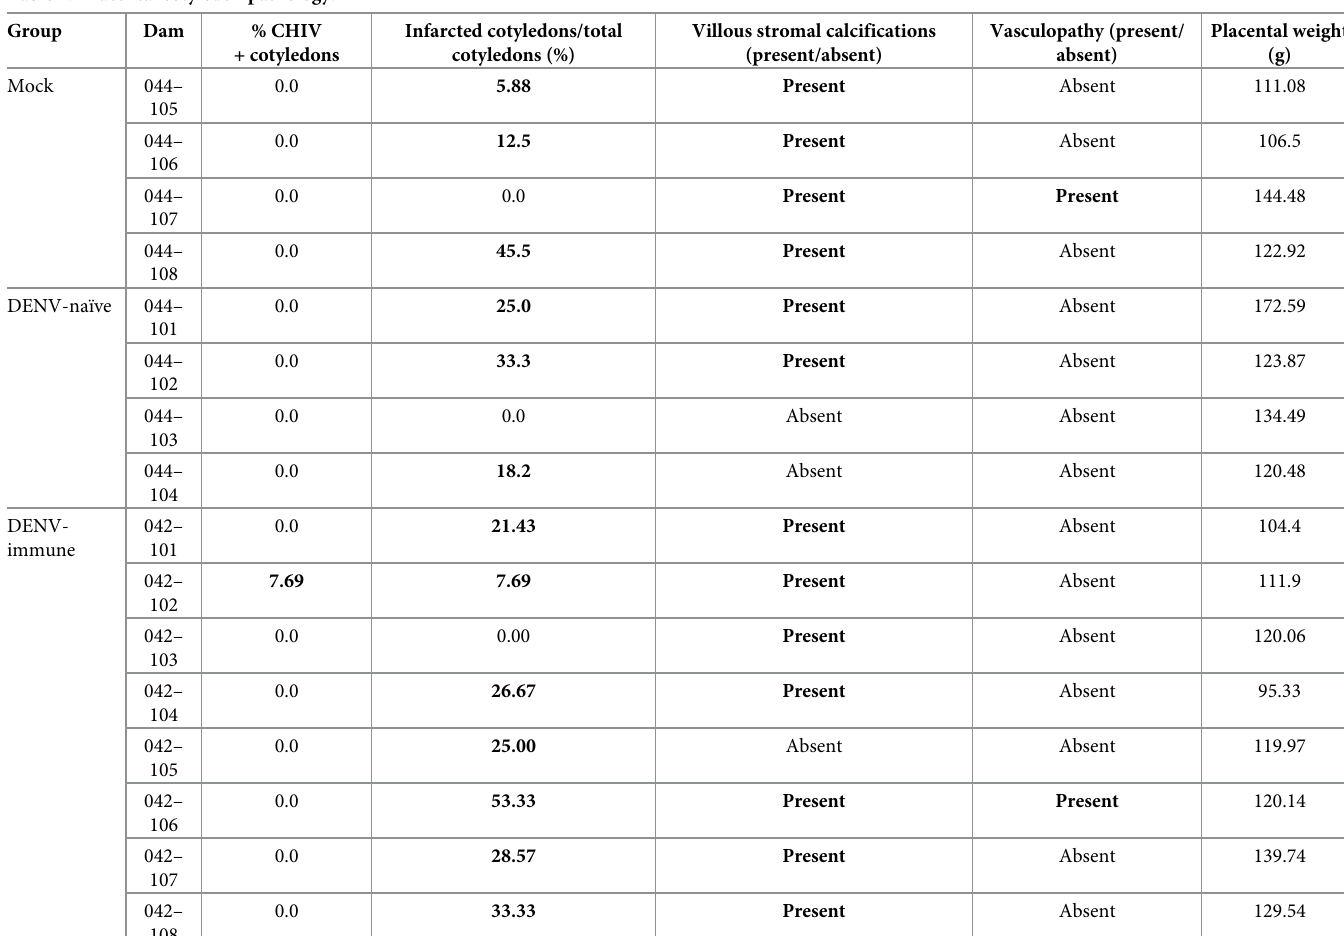
Table 1. Placental cotyledon